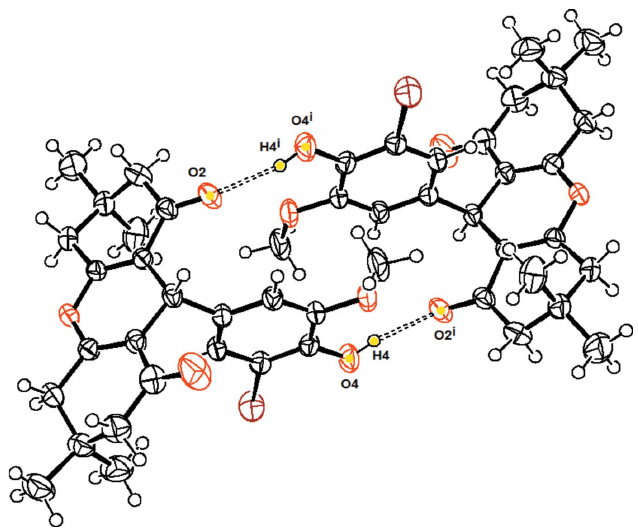
Figure 2 A view of the structure of (I) showing the O—H (cid:3)(cid:3)(cid:3) O hydrogen bonds, forming a centrosymmetric dimer with an R 2